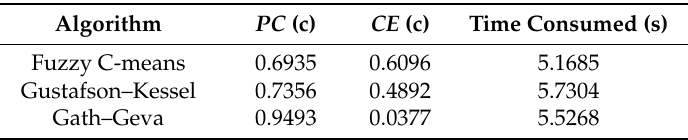
Table 5. Recorded data of the evaluation in three ways.